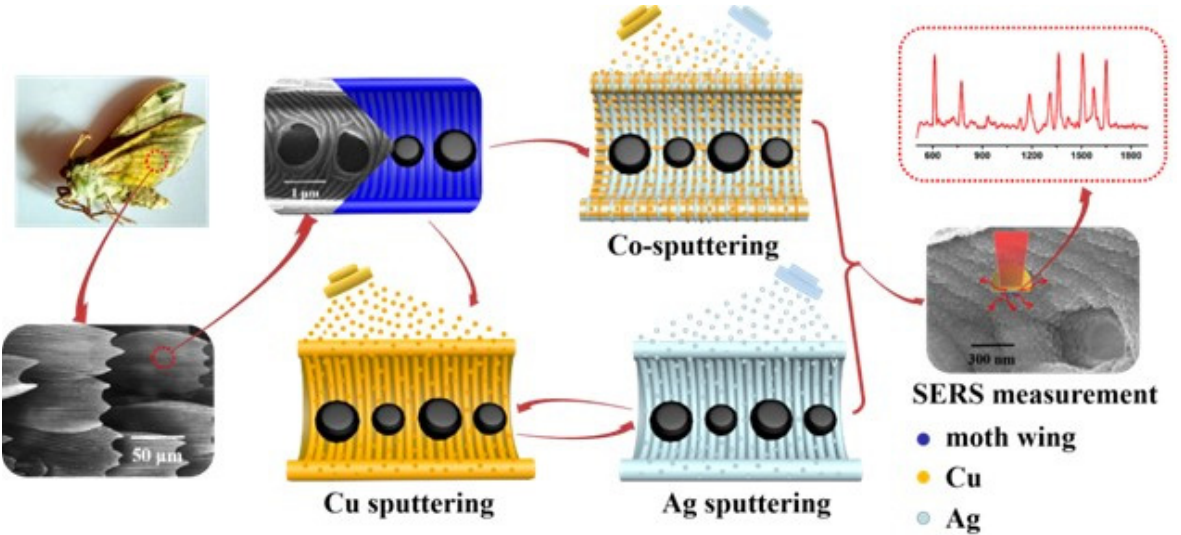
Figure 1. Schematic diagram of the fabrication process of the AgCu@MW and Ag@Cu@MW sub ‐ strates by co ‐ sputtering and sequentially alternating sputtering fashions, respectively.